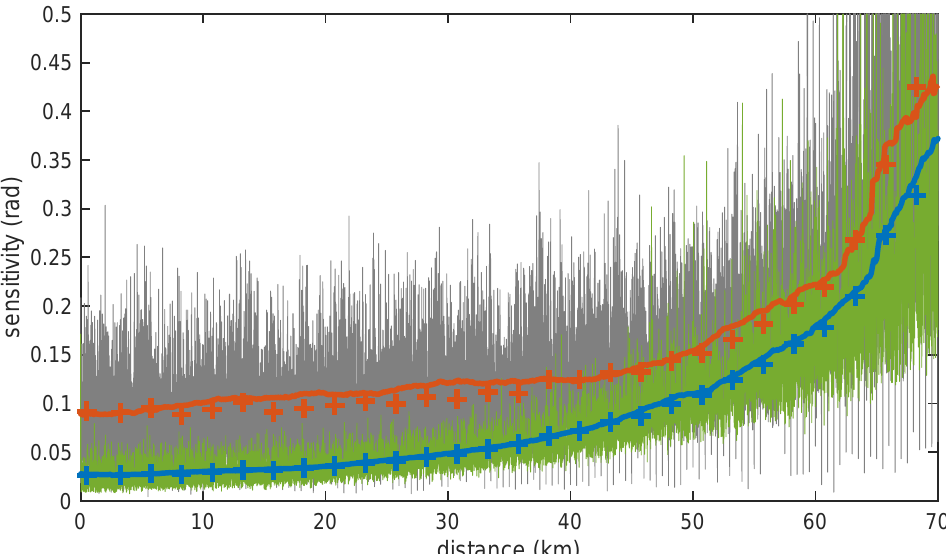
Figure 3. Sensor sensitivity along a 70-km measurement range using LFM OPC with 2-m spatial resolution and 6-m gauge length for two different laser sources: a 100-Hz linewidth NKT (green line) and a 4.1-kHz linewidth RIO modules (grey line). The figure also shows the measured (lines) and numerically calculated from the theoretical model (symbols) smoothed sensitivity data (blue and red for the NKT and the RIO modules, respectively).